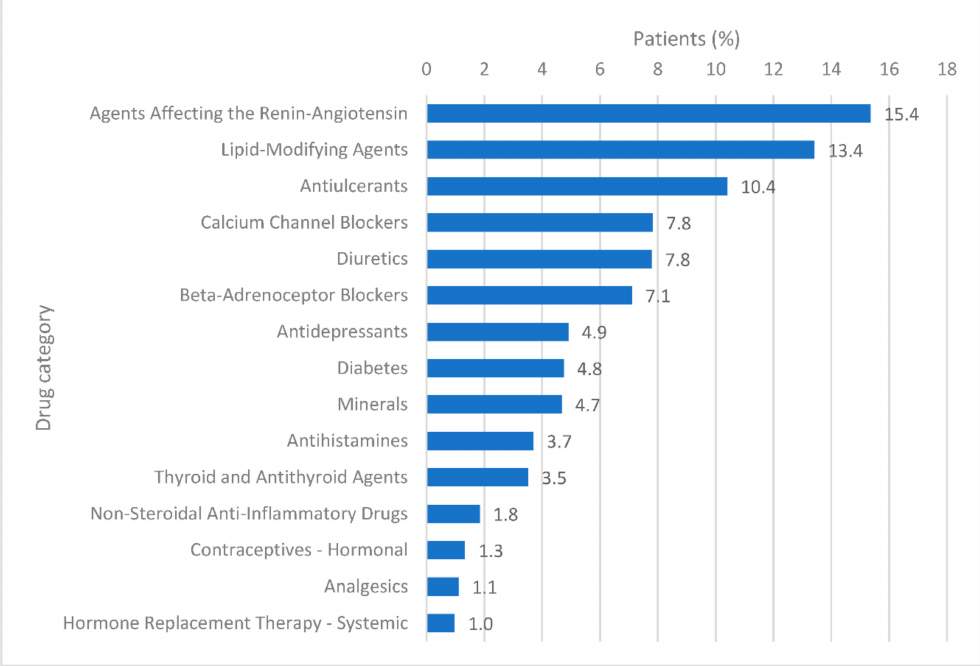
Figure 2. Patient proportions for each drug category, showing the 15 most common categories of a total of 57